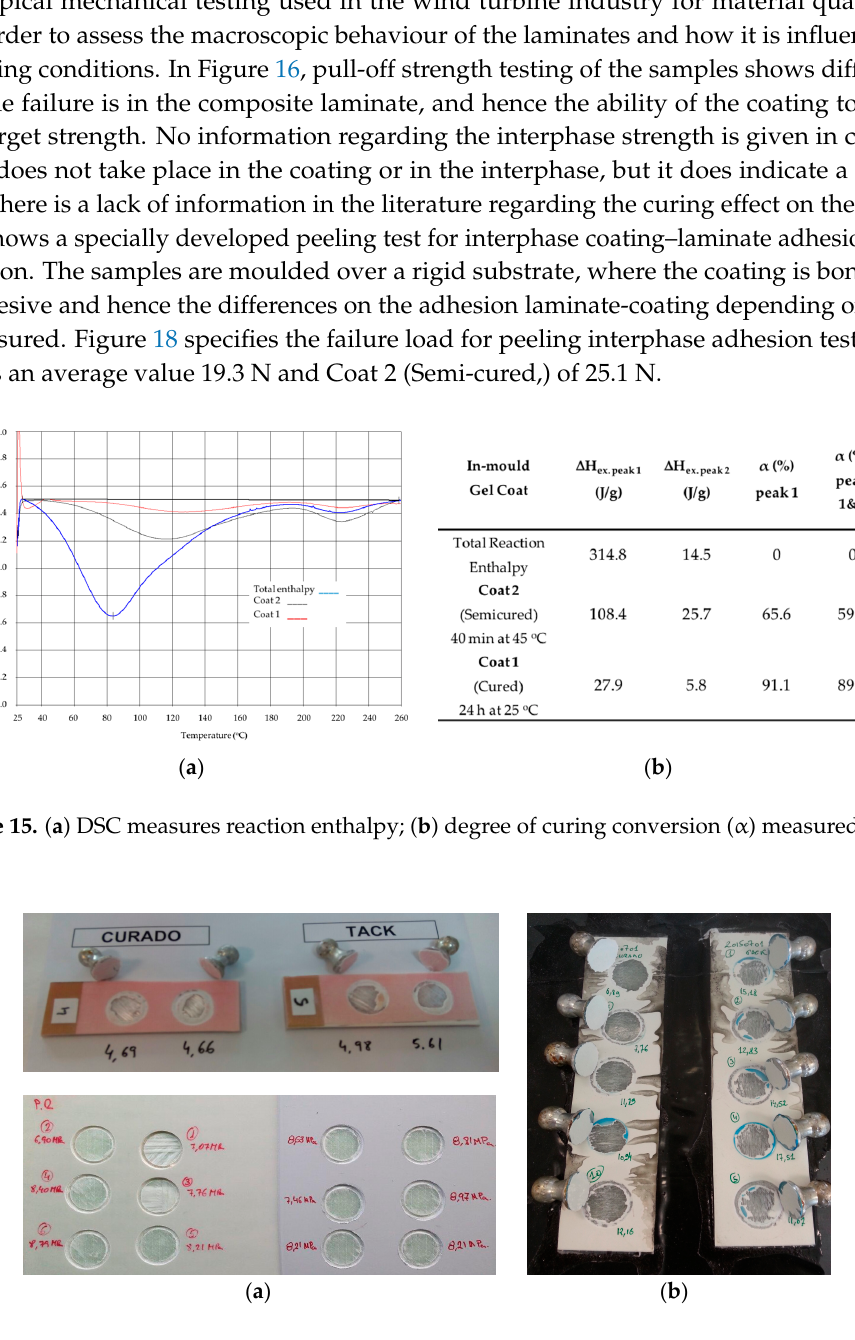
( c ) Figure 17. Developed peeling testing for interphase coating-laminate adhesion response quantification. ( a ) Developed specimens; ( b ) forces on testing; and ( c ) peeling testing system.